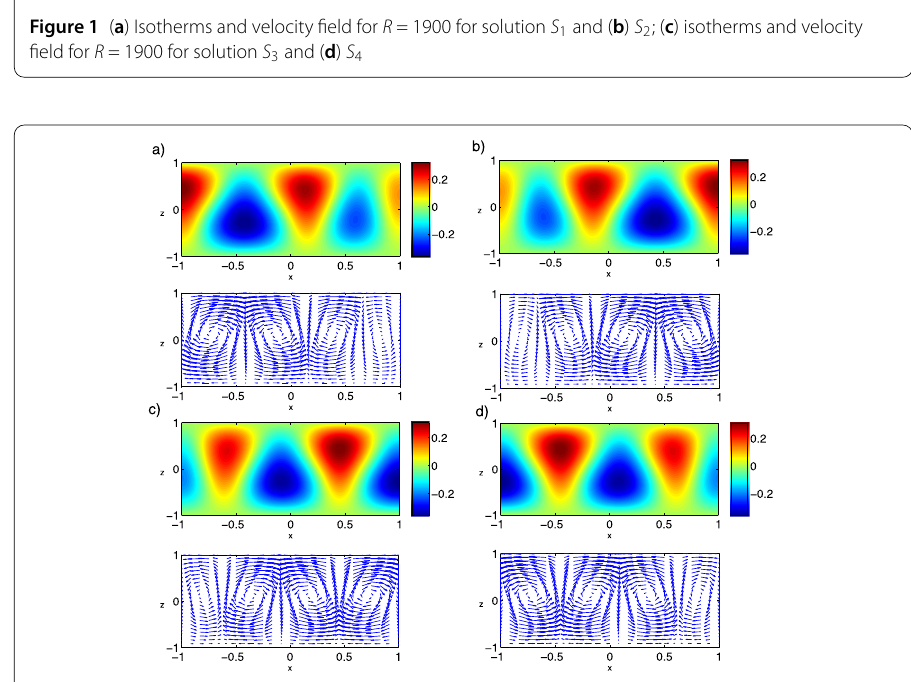
Figure 2 ( a ) Isotherms and velocity field for R = 1900 for solution S 5 and ( b ) S 6 ; ( c ) isotherms and velocity field for R = 1900 for solution S 7 and ( d ) S